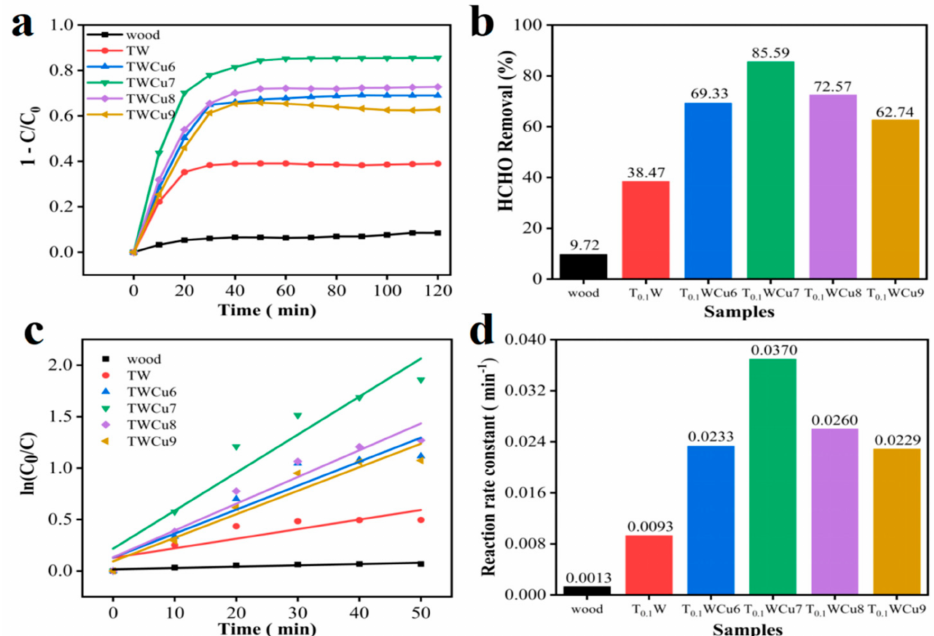
Figure 5. Two-hour photocatalytic reaction degradation efficiency ( a ) process and ( b ) results. ( c ) The kinetic curves and ( d ) the reaction rate constant